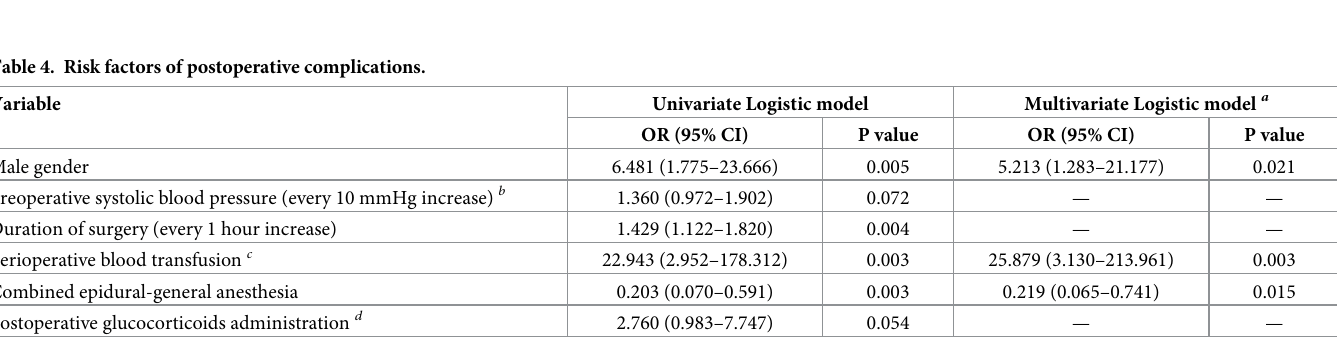
Table 4. Risk factors of postoperative